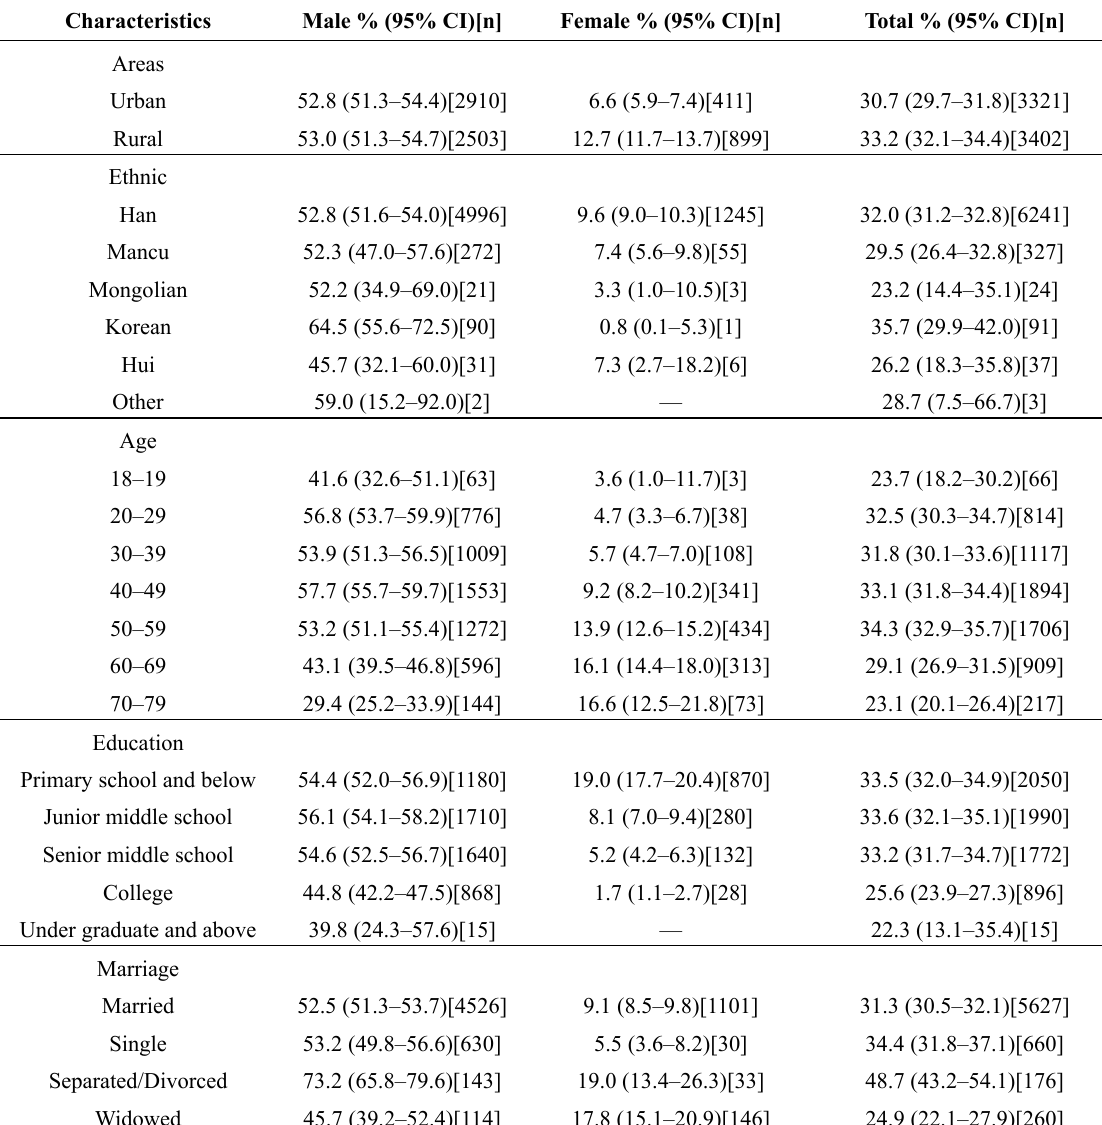
Table 2. Characteristics of current smoking status of adults from Jilin Province, China in